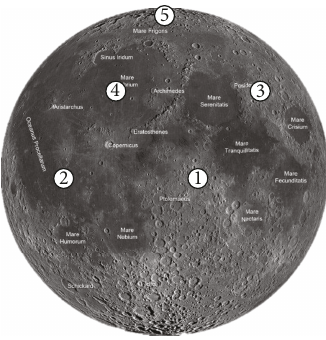
Figure 1: Landing candidate areas of a lunar lander